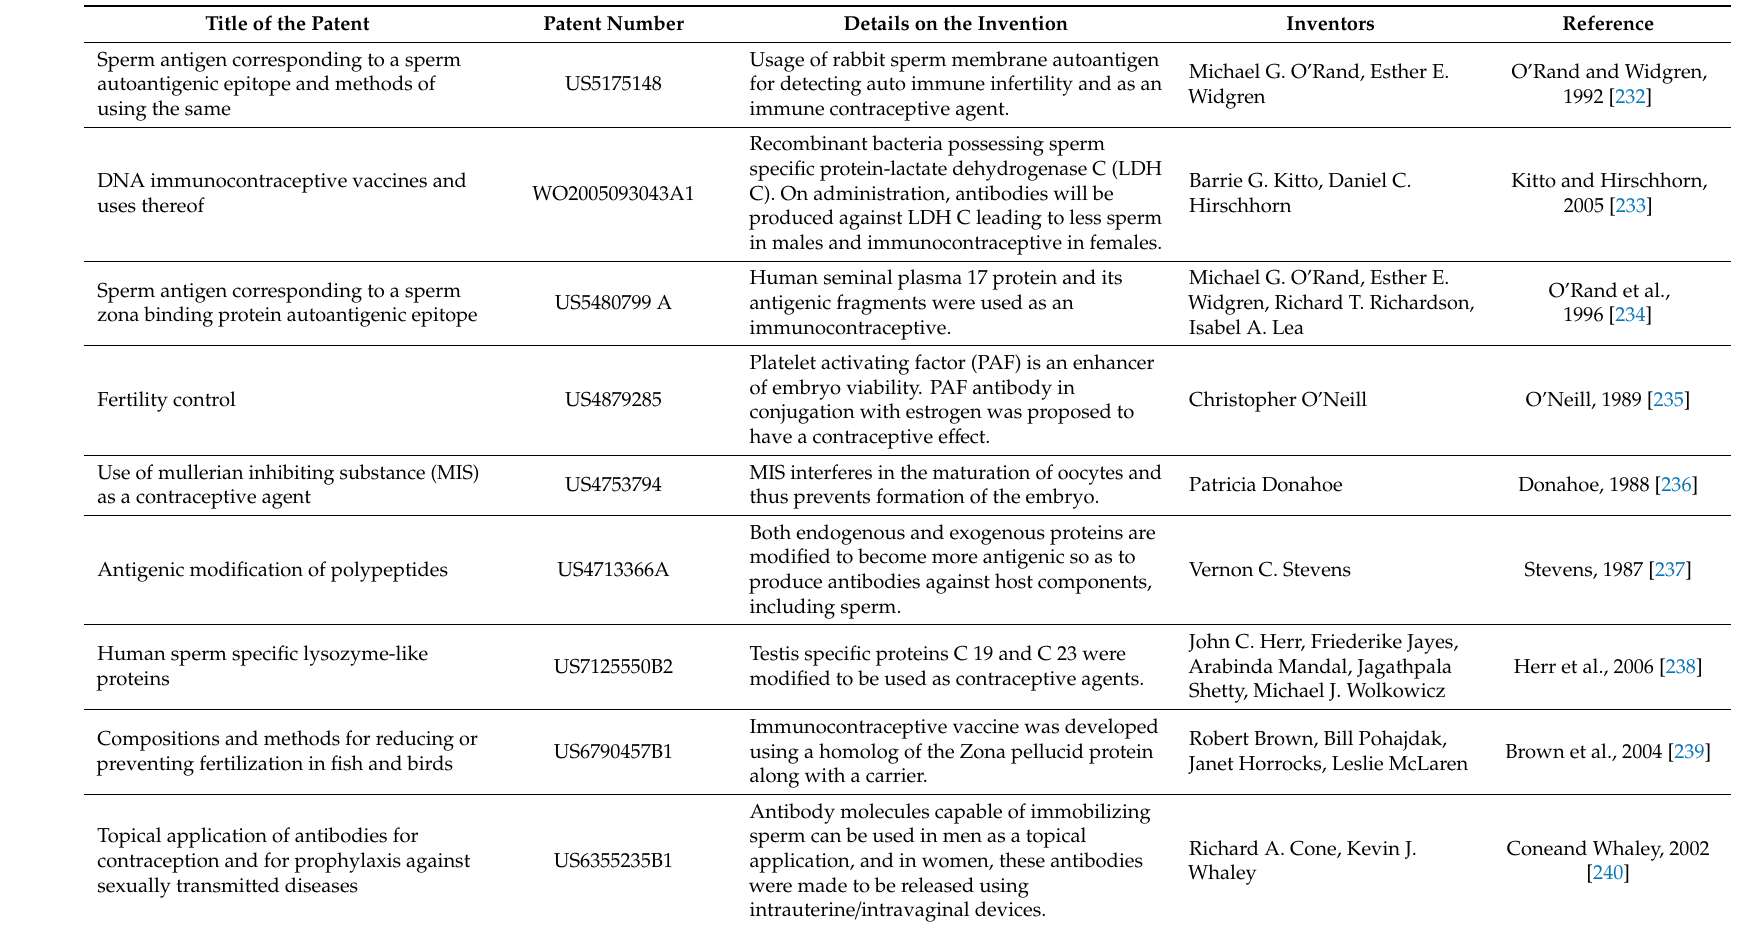
Table 1. Patents related to antisperm antibodies and male